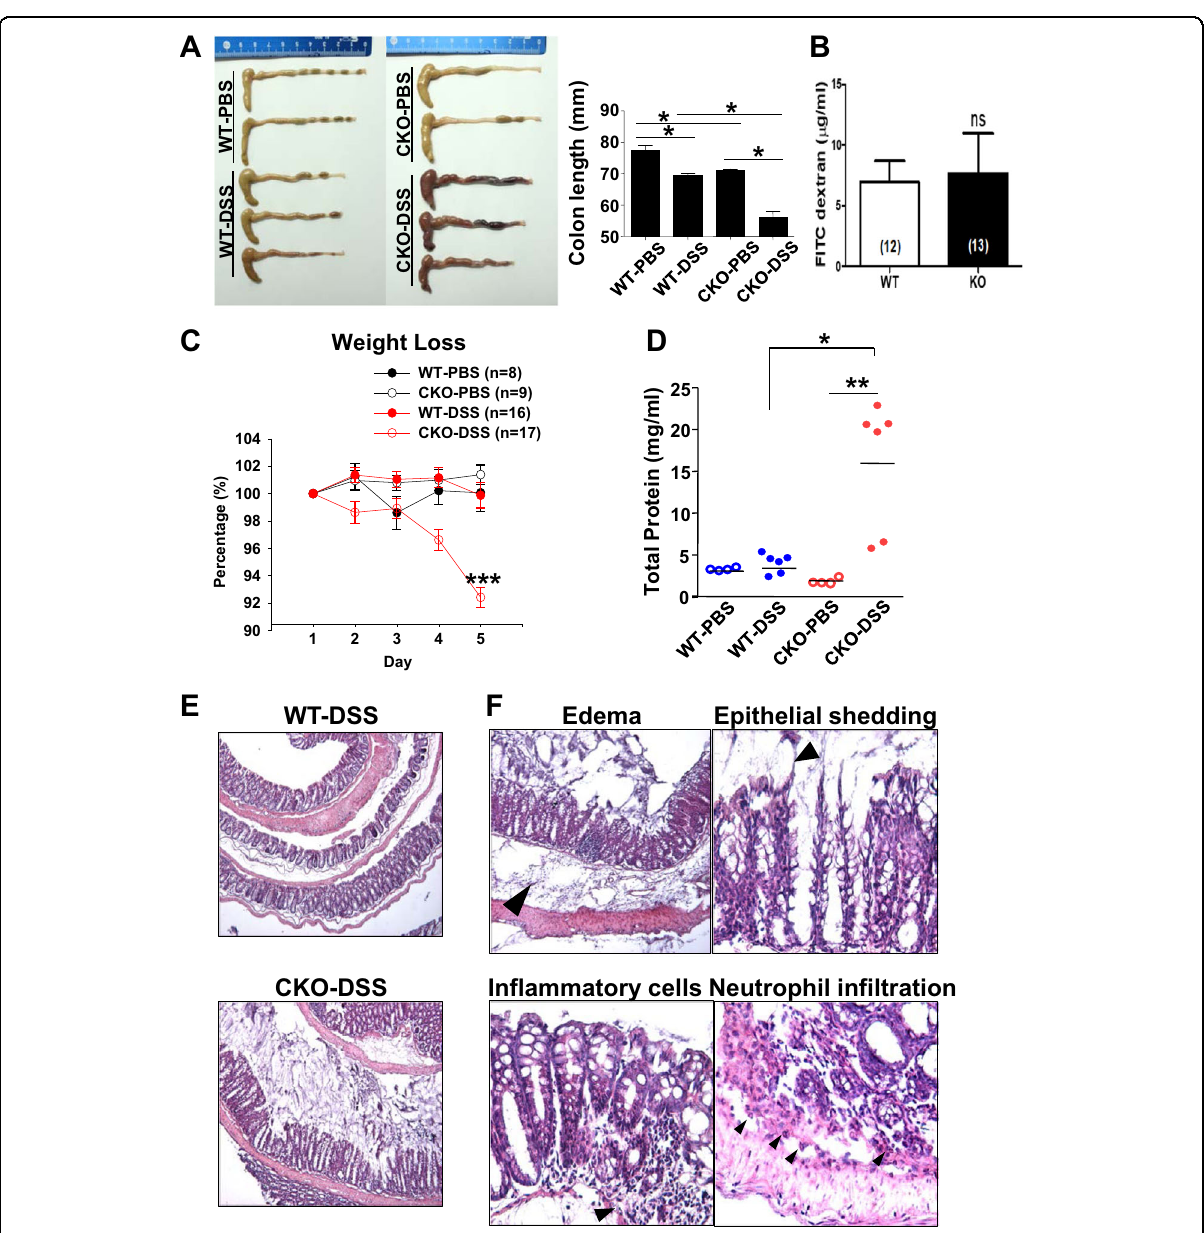
Fig. 6 Acute treatment with dextran sodium sulfate induces severe colitis in CKO mice. a Colons isolated from Ano1 fl / fl (WT) and Cdx2-Ano1 fl / fl